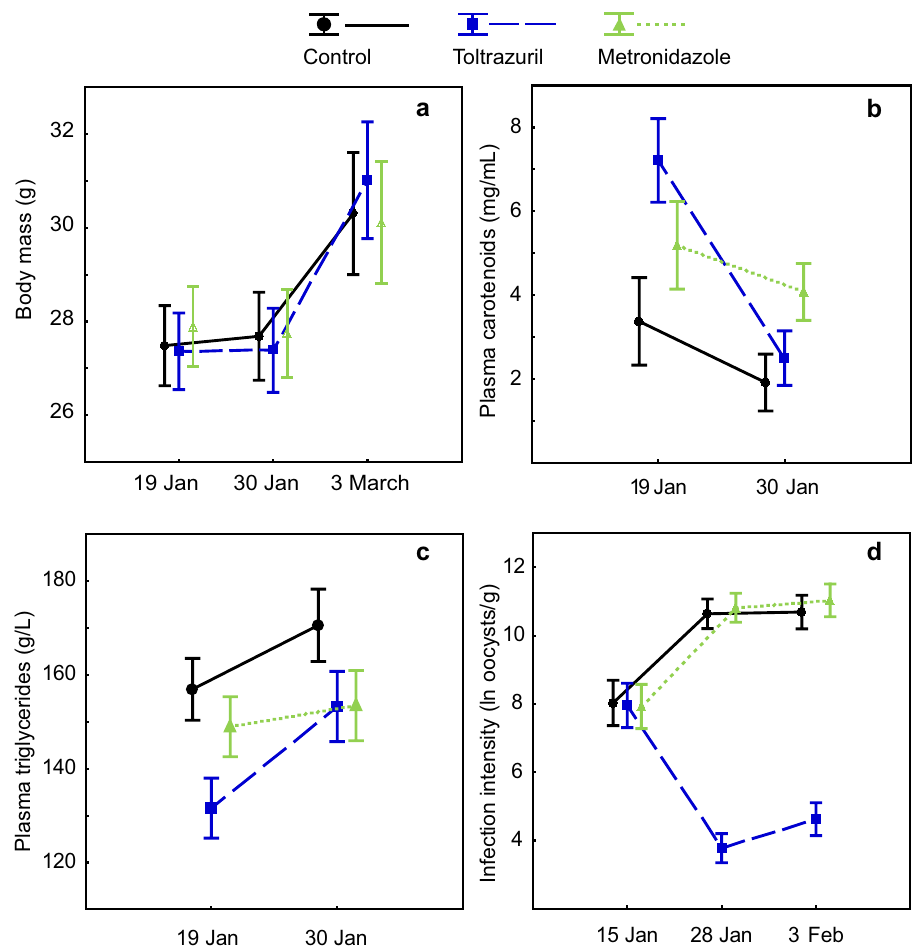
Figure 5. The effect of treatment on body mass, plasma carotenoids, plasma triglycerides, and coccidian infection intensity. ( a ) Treatment did not affect the body mass of birds. ( b ) Treatment had an effect on plasma carotenoids—carotenoids were significantly higher in the toltrazuril group pre-treatment, but after medication, there were no differences between the groups. ( c ) Treatment did not affect plasma triglycerides. ( d ) Medication with TOLTRA significantly reduced the intensity of coccidian infection, while birds medicated with metronidazole (METRO) did not differ from the control group (modification of a previously published figure by R. Meitern and co-authors 34 (https:// doi. org/ 10. 1002/ ece3. 2575, licensed under CC BY 4.0 https:// creat iveco mmons. org/ licen ses/ by/4. 0/). The effects were examined with repeated measures ANOVA (Table 1). Whiskers denote mean ±